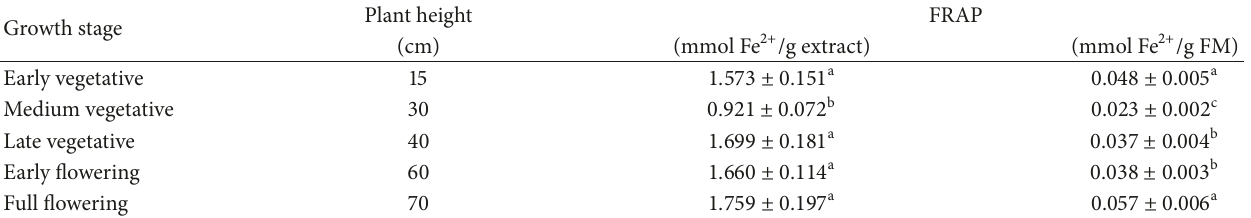
Table 5: Ferric-reducing antioxidant power (FRAP) of the perilla extract and fresh matter (FM) at different growth stages. Growth